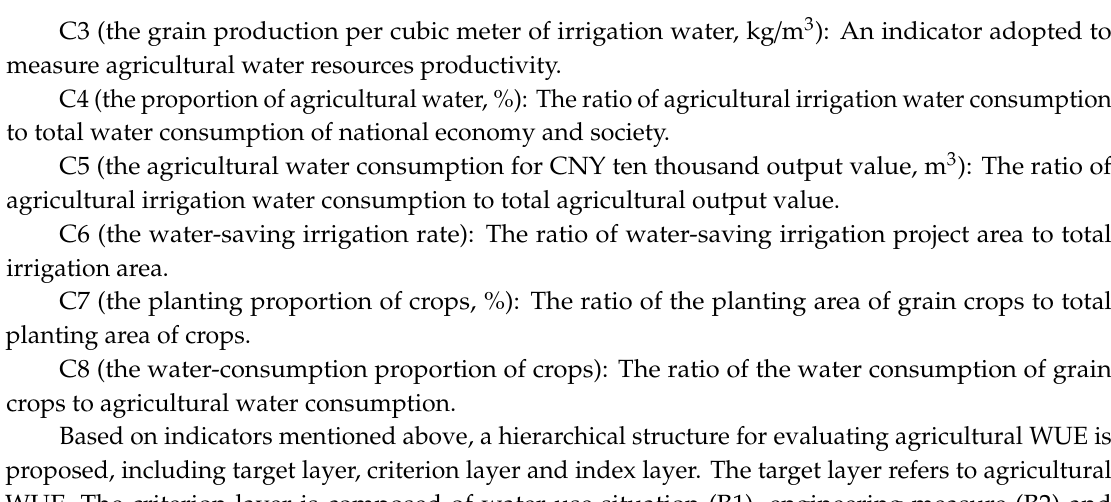
Figure 2. Evaluation system of agricultural water use efficiency in Xinjiang.